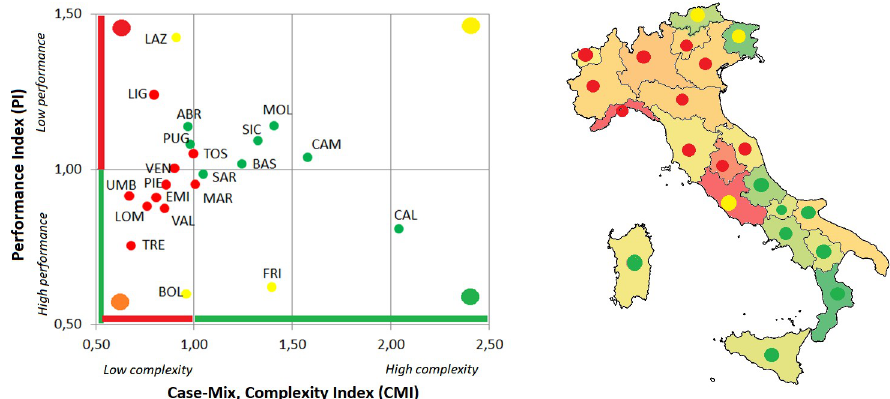
Fig 5. Overall classification of each Italian region considering both the hospital bed management indicators and the complexity and performance indicators of intensive care units. In both figures the colour of the marker captures the hospital bed management classification. In the Italian map, regions are coloured on the basis of the ratio between the CMI and PI.